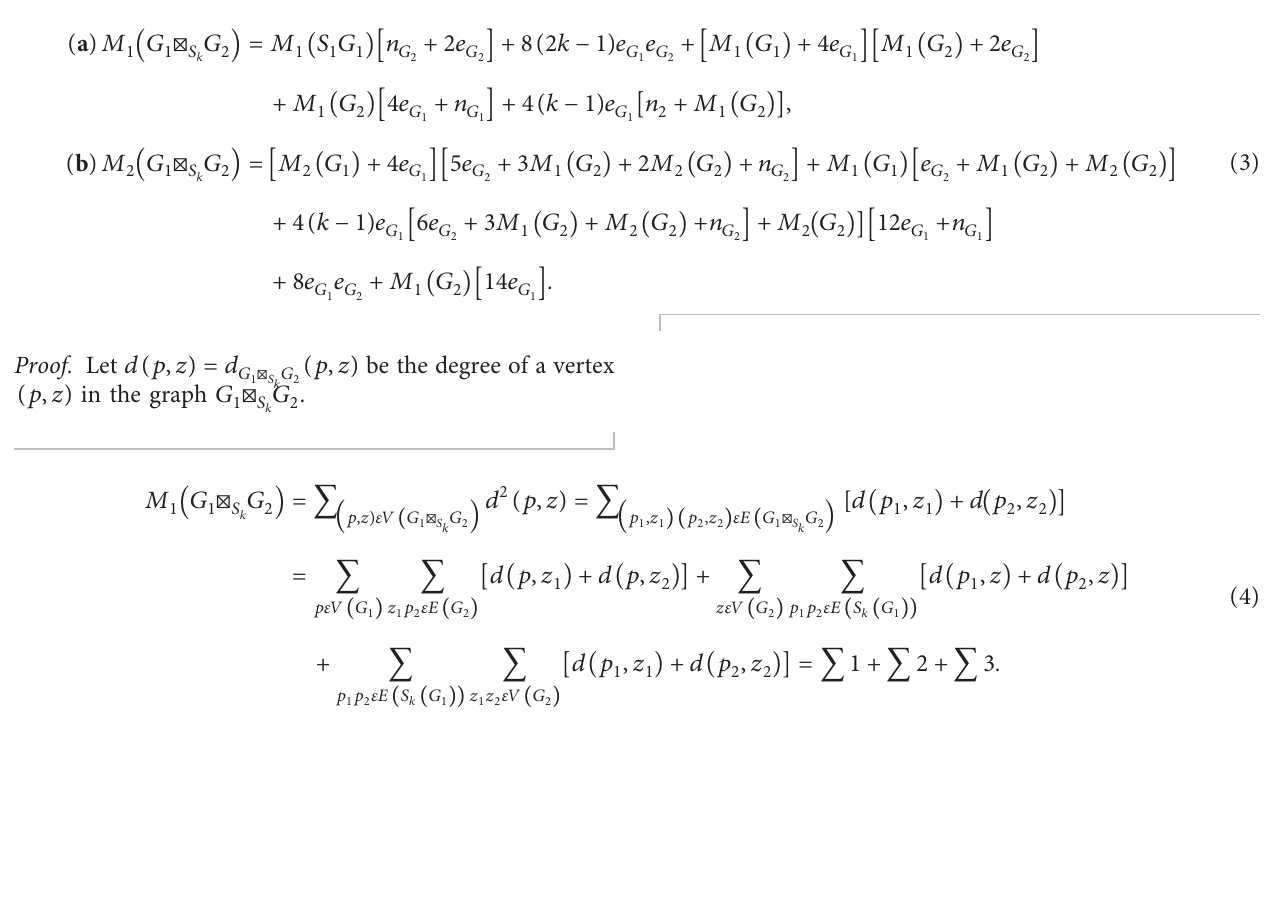
Figure 4: (a) Graphical representation of M colour, respectively. (b)